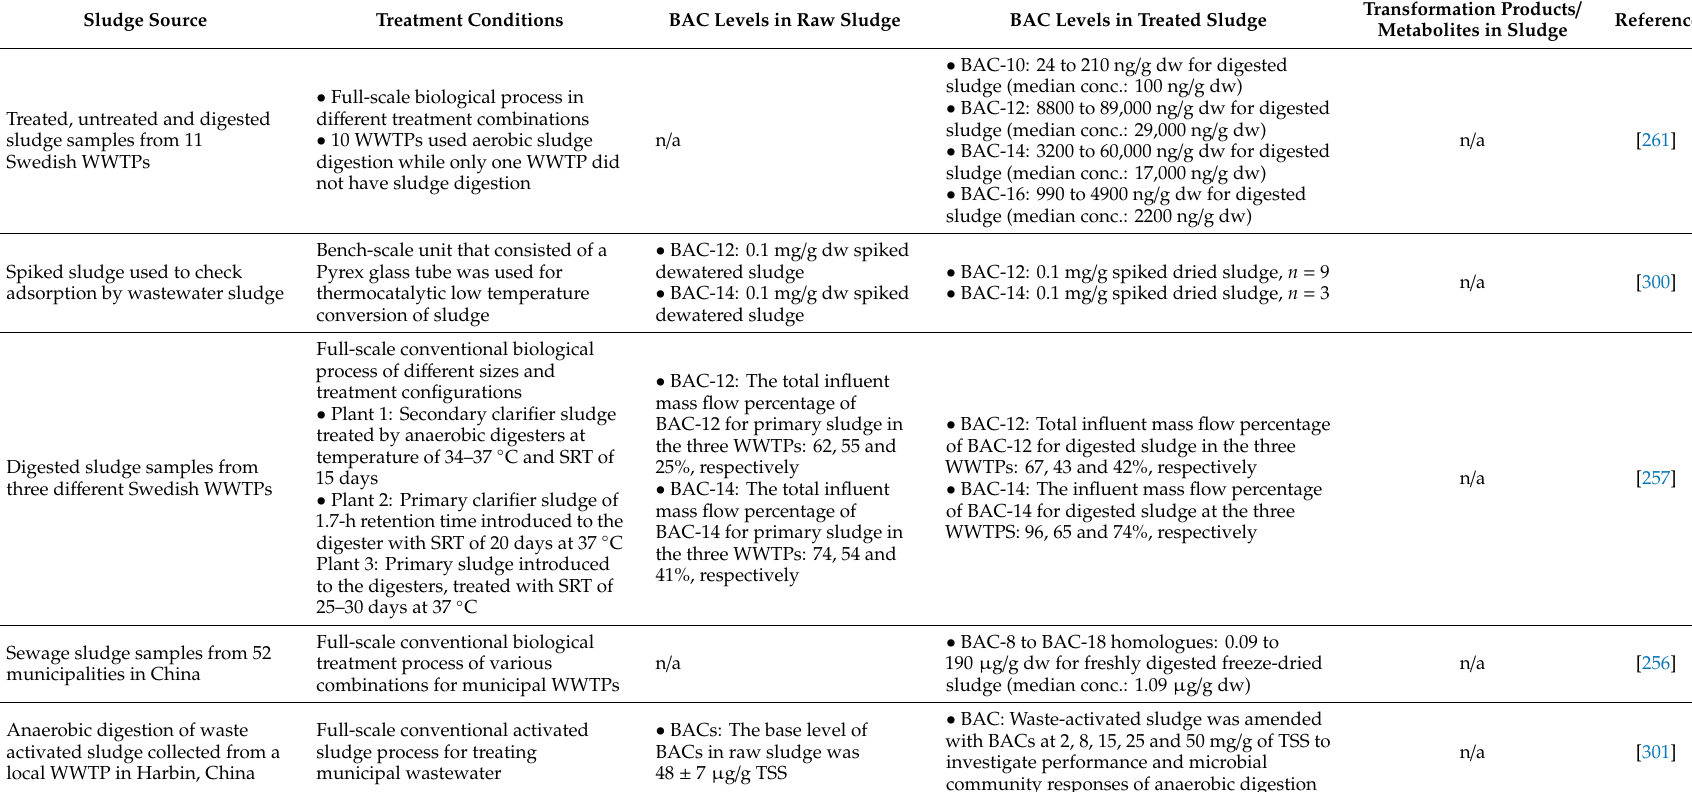
Table 6. Occurrence of benzalkonium chlorides in sludge and